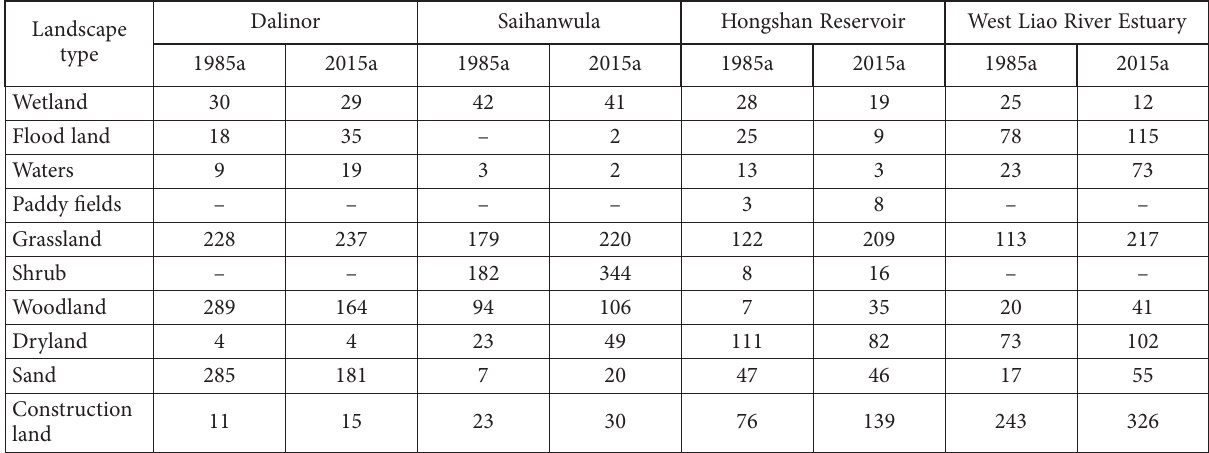
Table 6. Changes in the number of landscape patches in each study area